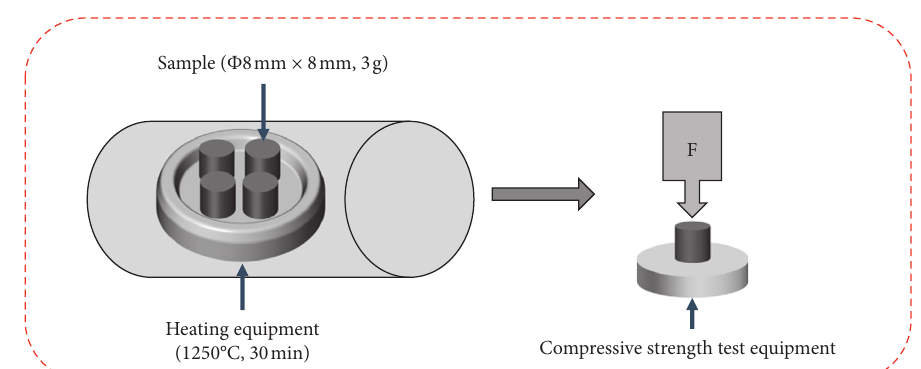
Figure 3: Diagrammatic chart of compressive strength of bonding phase.